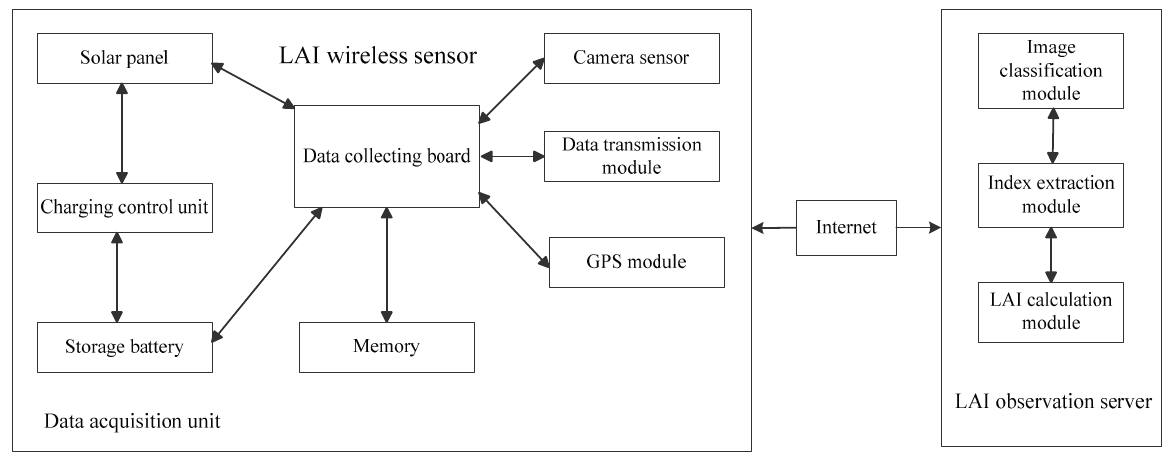
Figure 1. System structural framework.